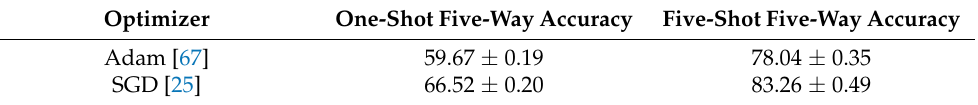
Table 7. Comparison of the accuracy (%) of the five-way task when performed with five shots and one shot (%) between SGD and Adam optimizer. Ninety-five percent confidence intervals are provided for all results.